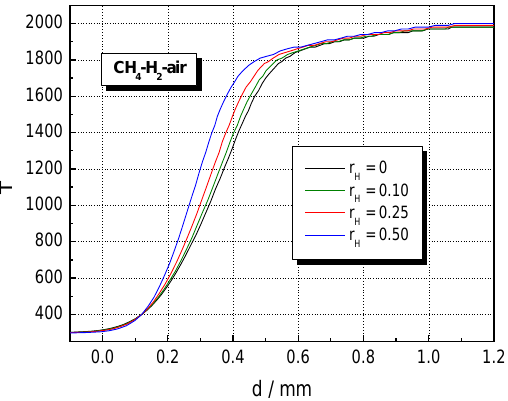
Figure 7. Computed temperature profiles in the flame front of stoichiometric CH 4 –H 2 –air flames with variable r H ; ambient p 0 and T 0 .